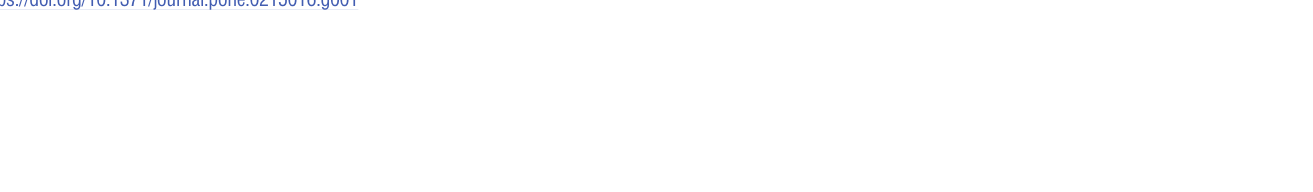
PLOS ONE | https://doi.org/10.1371/journal.pone.0215016 April 9,